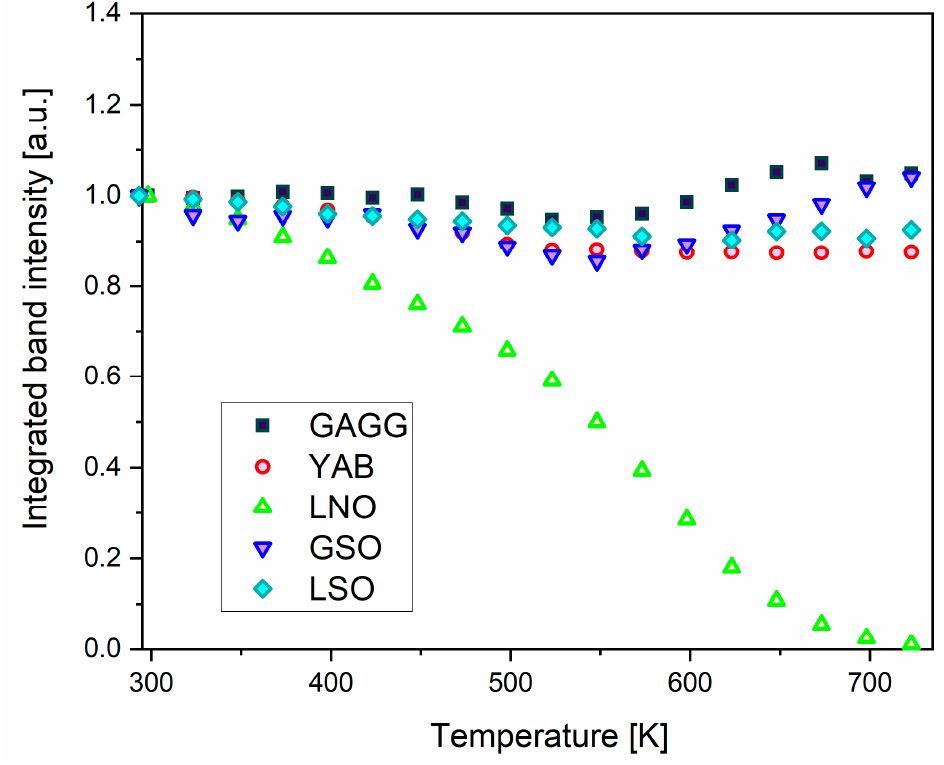
Figure 5. Integrated Dy 3+ luminescence intensity within the 425–800 nm region at different temperatures between 295 K and 725 K. Results were normalized to unity at 295 K.